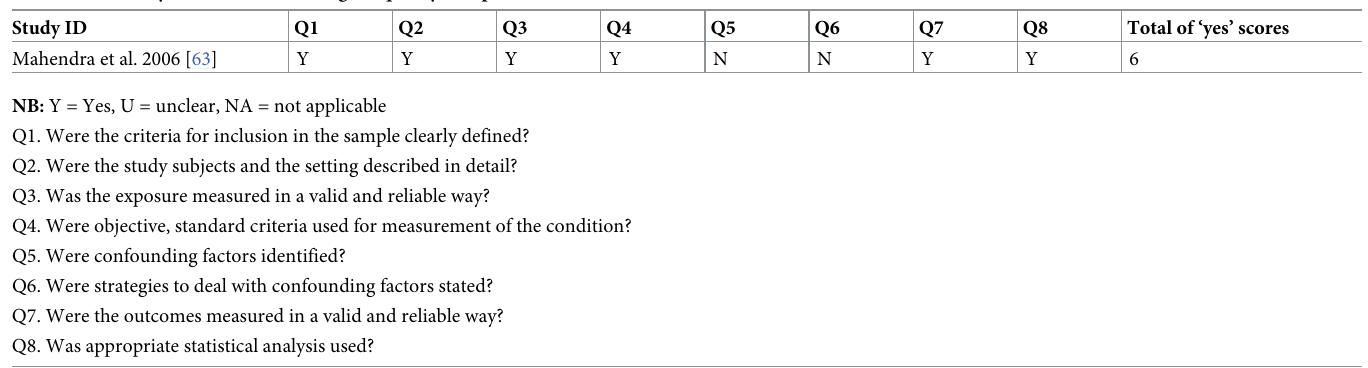
Table 4. Summary score for methodological quality of repeated cross-sectional studies.